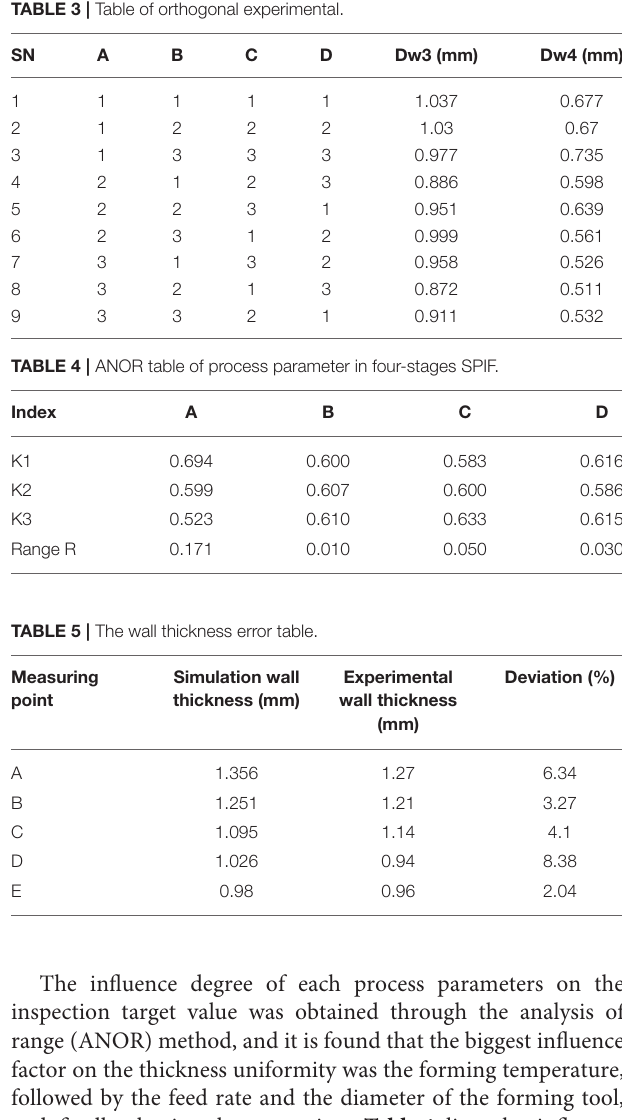
SPIF; the thickness uniformity is significantly worse than the optimal result, but it is better than the result using